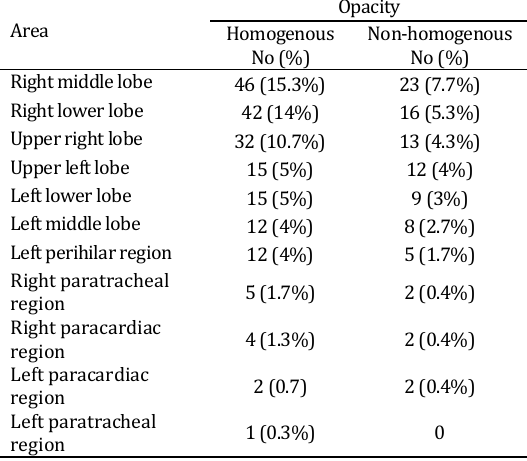
Table 2. Regions of homogenous and non-homogenous opacity in the 500 flexible fiberoptic bronchoscopy patients